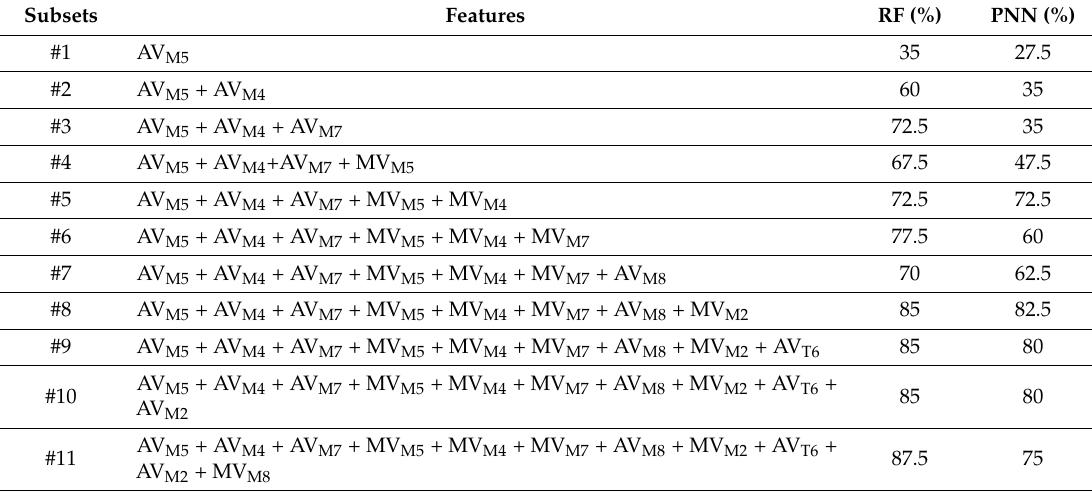
Table 3. Comparison of the results based on different classification models.